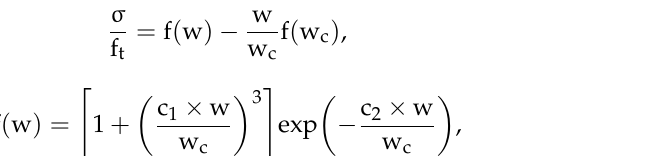
Figure 13. Parameters of concrete in compression, an extension of EN 1992-1-1 model.